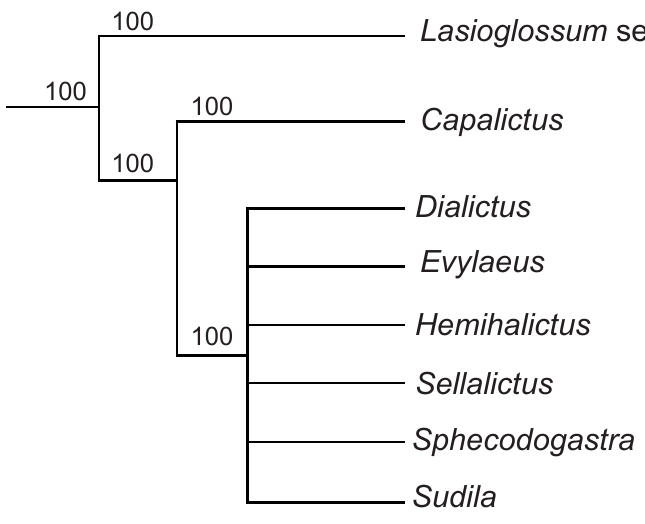
Fig. 18. Summary of phylogenetic relationships of Capalictus relative to remaining Lasioglossum , based on Gibbs et al. 2012. Numbers represent posterior probability support